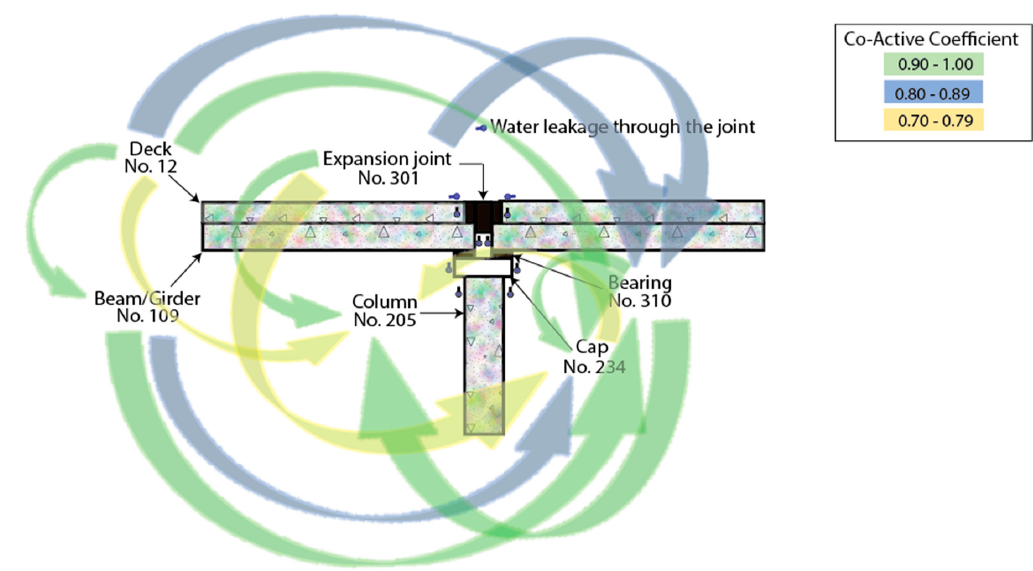
Figure 10. Dominant inter-dependencies among the Co-Active elements in the group PC109.